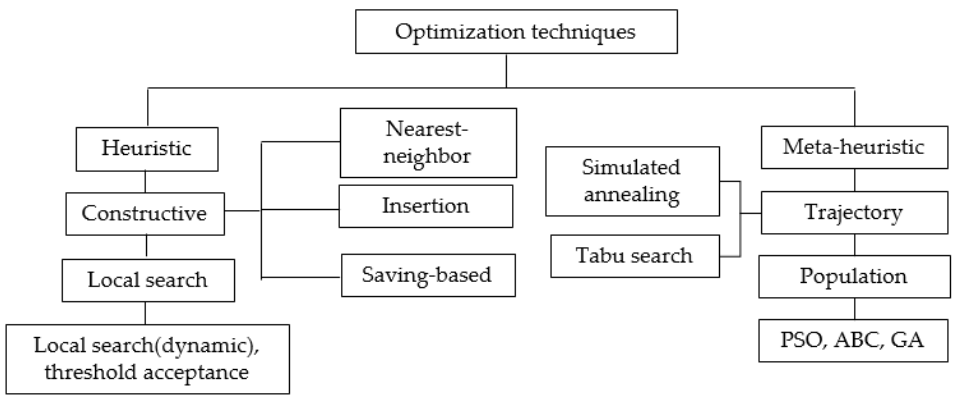
Figure 4. Taxonomy of optimization techniques.